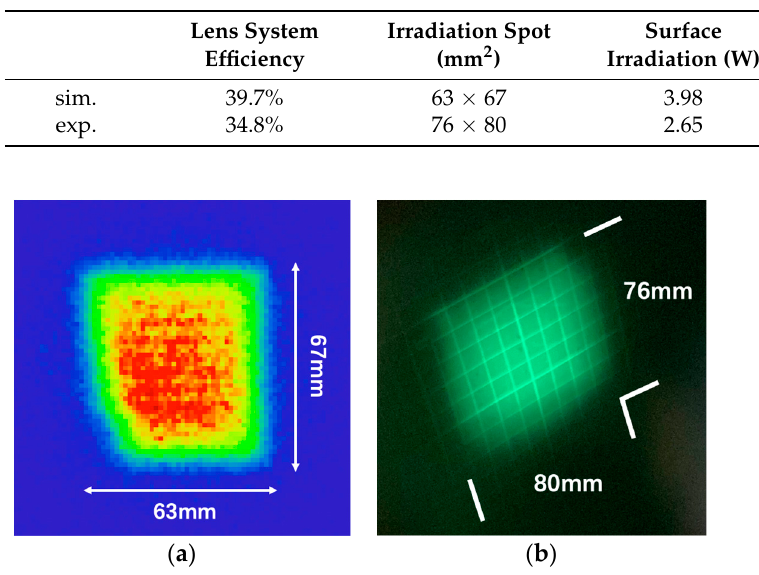
Figure 7. Irradiation spot at 1 m, ( a ) simulation; ( b )